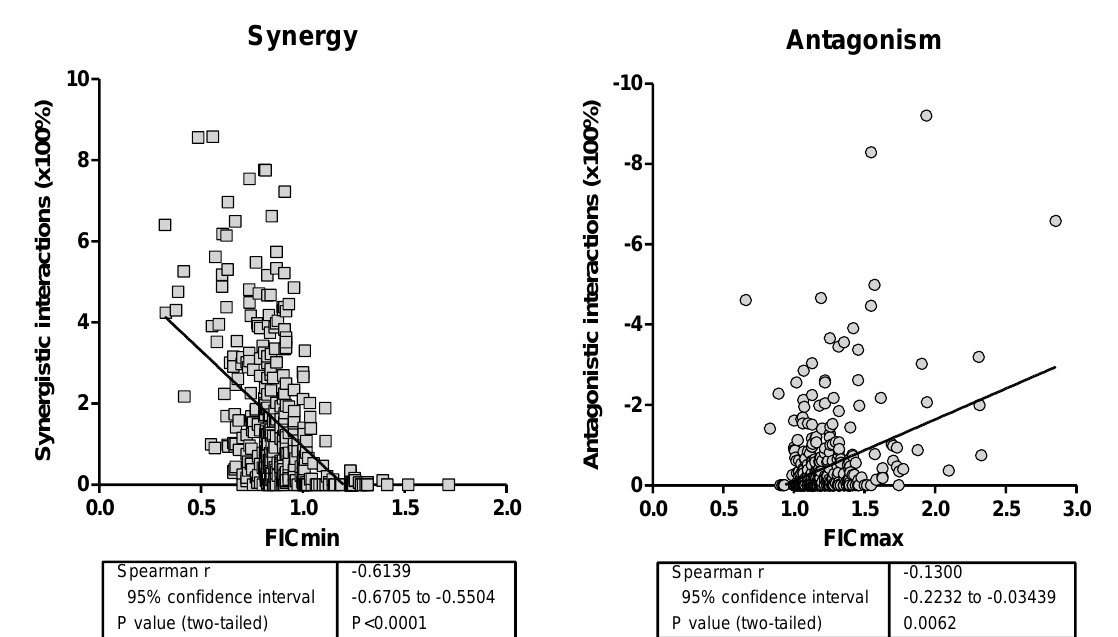
Figure 2. Spearman’s correlation analysis between ∑ FIC min and Bliss antagonistic interactions (left graph) and ∑ FIC max and Bliss antagonistic sum interactions (right graph). Table 4. Chi square analysis of the FIC index and BIRS analysis. Loewe